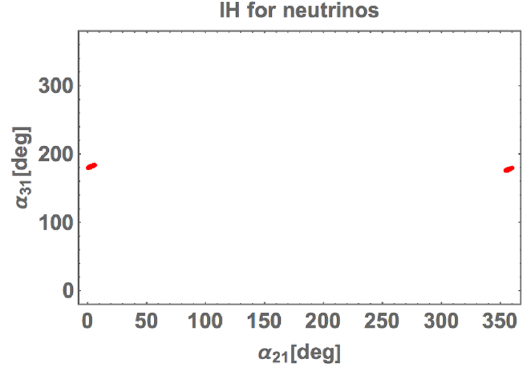
Figure 11 . Predicted Majorana phases α 21 and α 31 for IH.